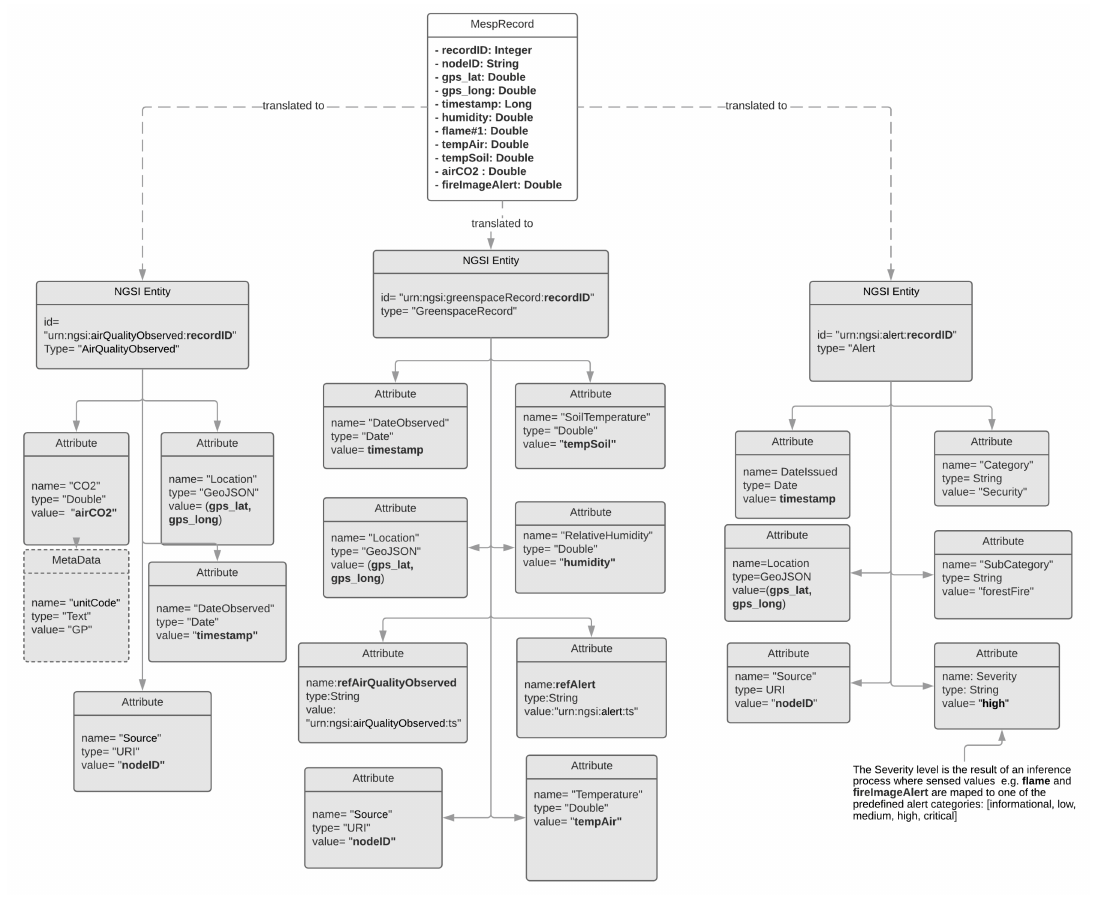
Figure 7. Data object model demonstrating the MESP record translation process to